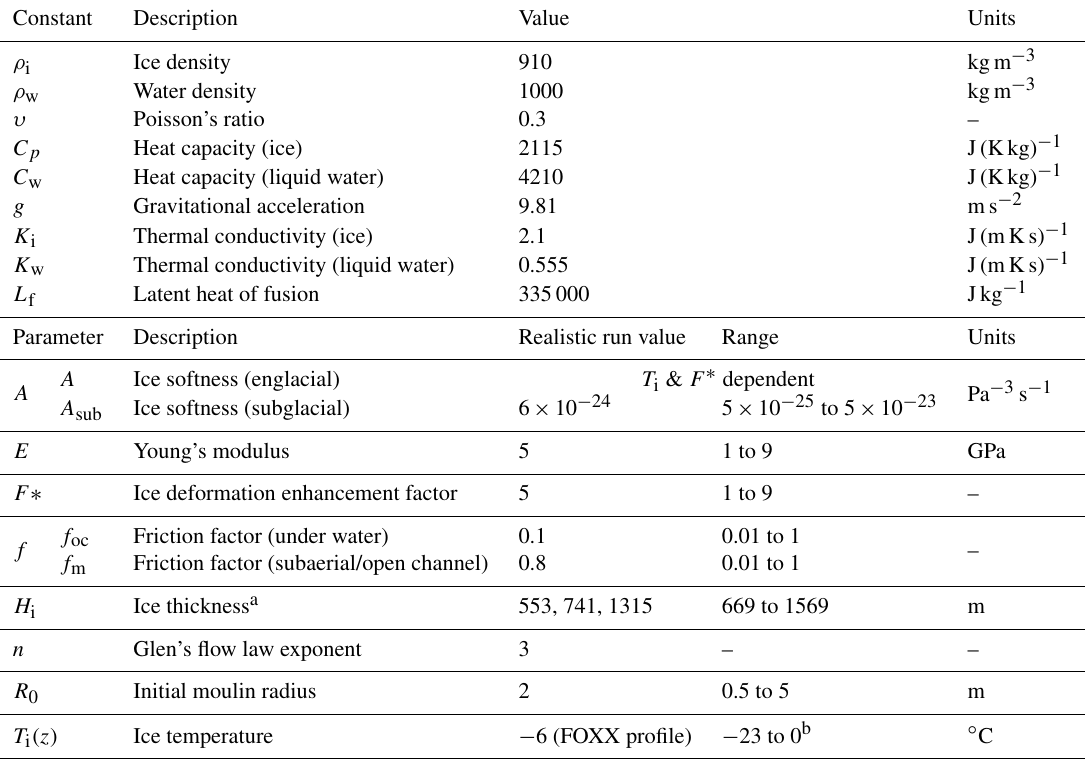
Table 1. MouSh model constants and parameter ranges. During realistic runs (Sect. 2.5.3) Values used during realistic model experiments are generally the median value of the sensitivity